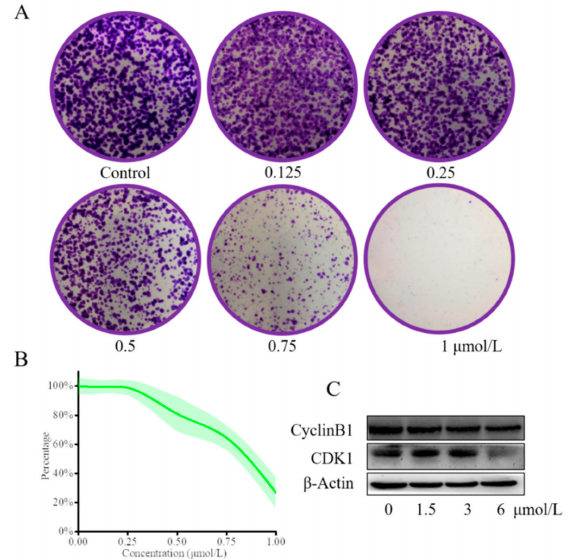
Figure 5. Compound 13e inhibited cell proliferation. ( A , B ) The colony formation of MGC-803 cells after the treatment with indicated concentrations of compound 13e for 7 days; ( C ) Cell proliferation related proteins in MGC-803 cells of compound 13e after the treatment with indicated concentrations of 13e for 24